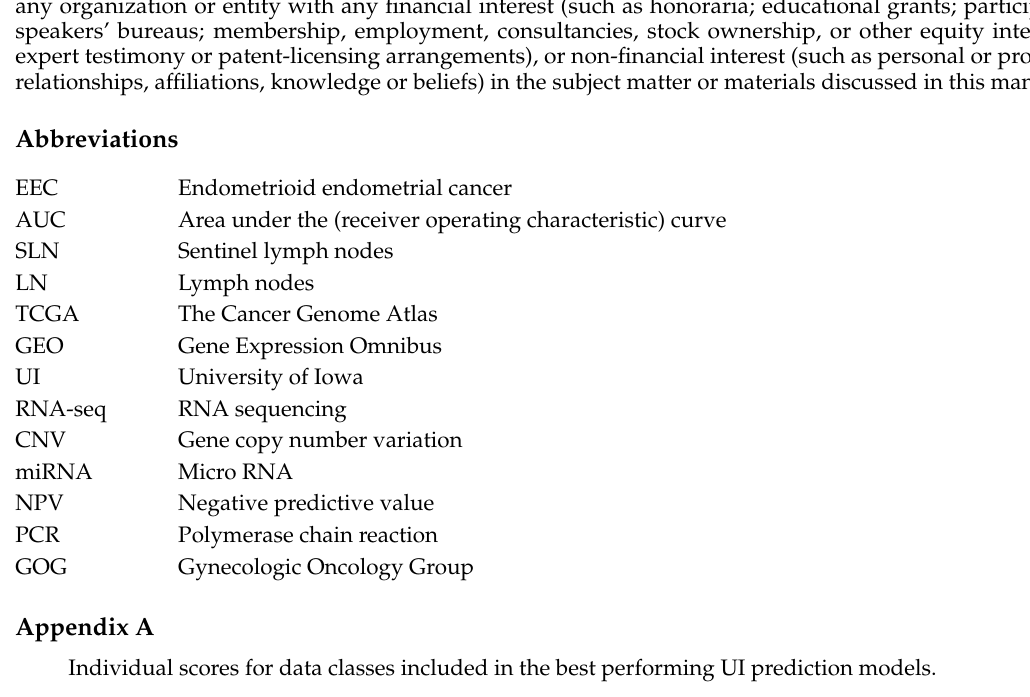
Table A1. Details of individual weights for miRNAs. For individual scores multiply the log2 transformed and normalized miRNA expression value by the weight in the table. Each model has different